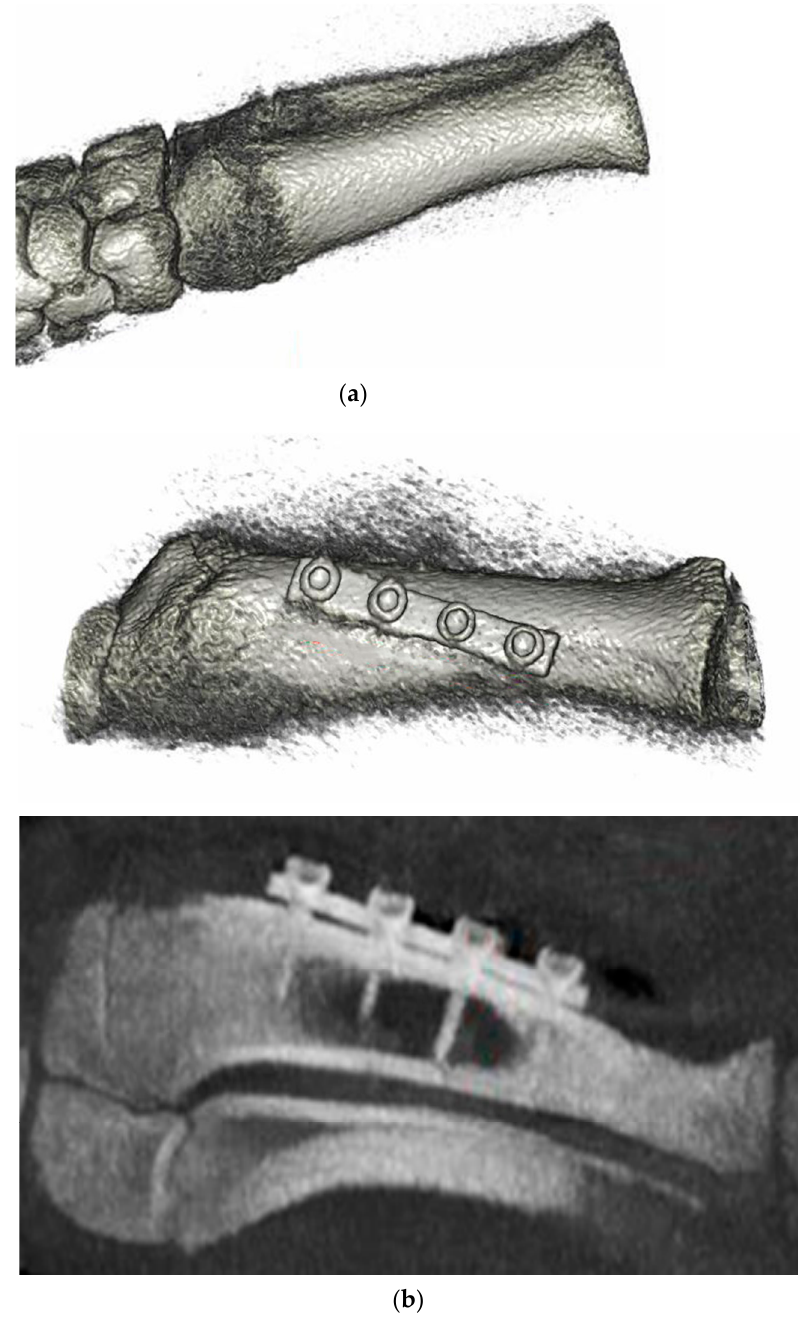
Figure 13. Micro-CT images: ( a ) before and ( b ) after surgery.